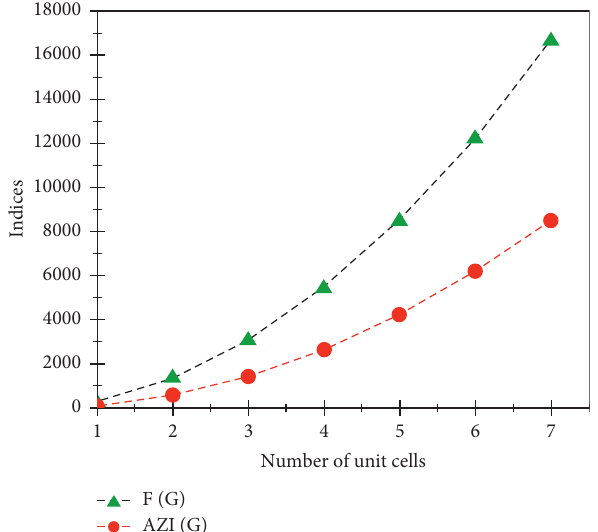
Figure 6: Comparison of F ( G ) and AZI ( G ) indices for InP [ s,t ]